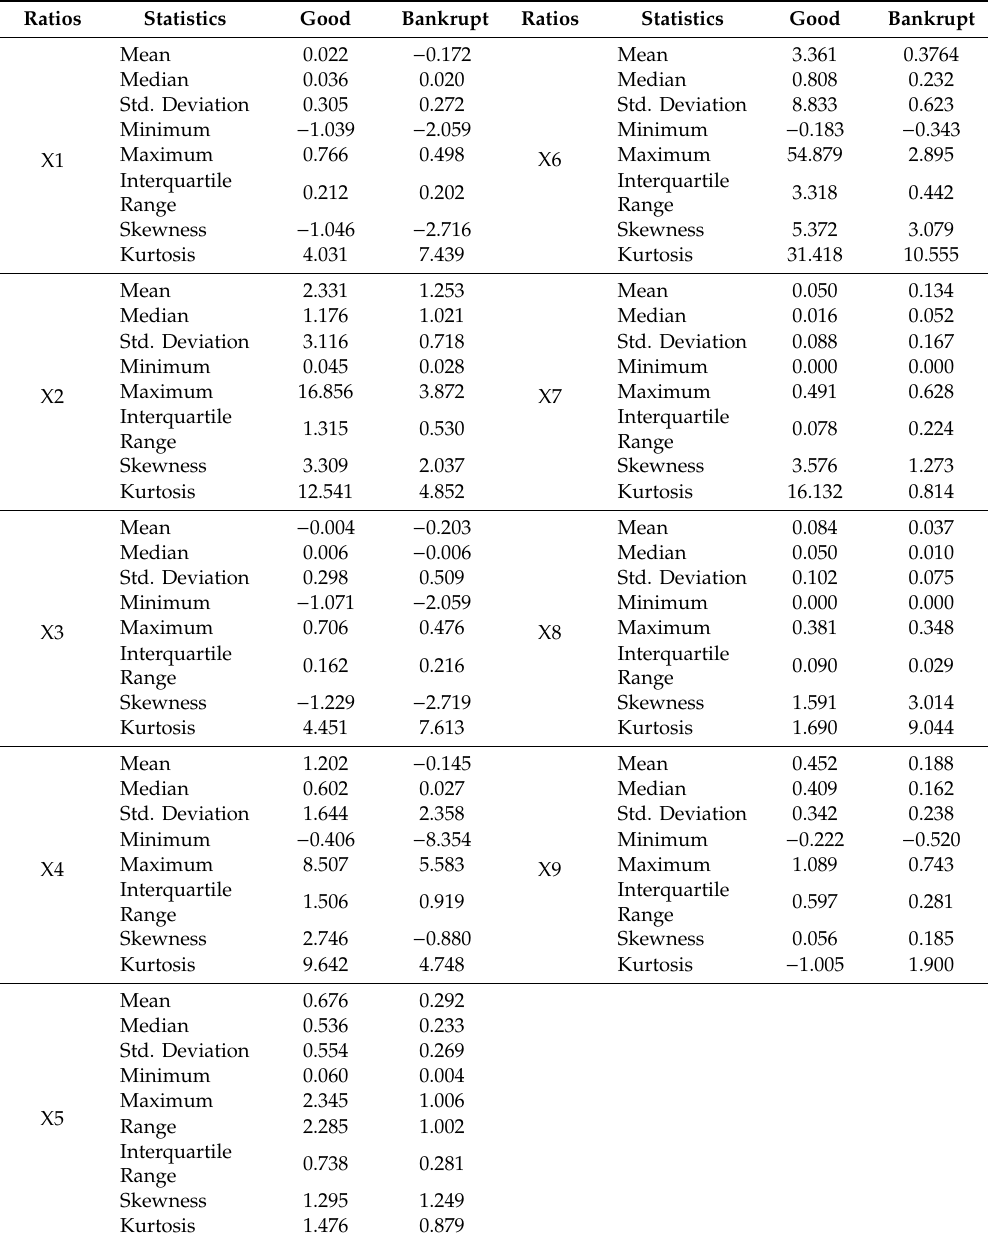
Table 3. Descriptive statistics of the nine variables extracted from the preliminary analysis of the learning